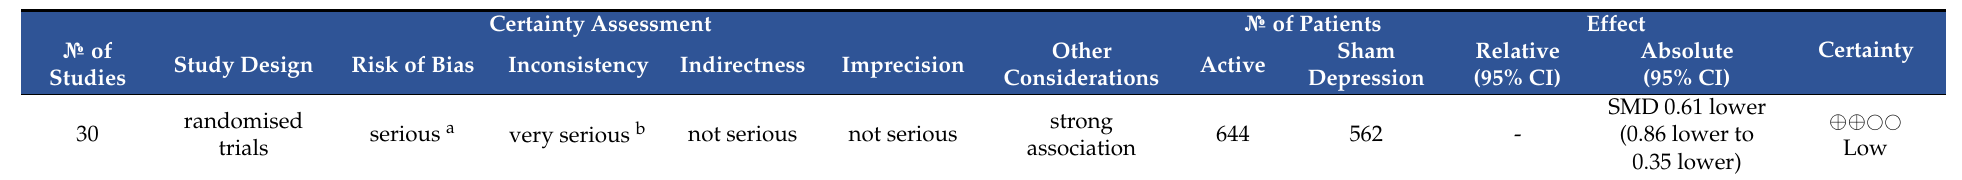
Table 6. GRADE assessment depression.